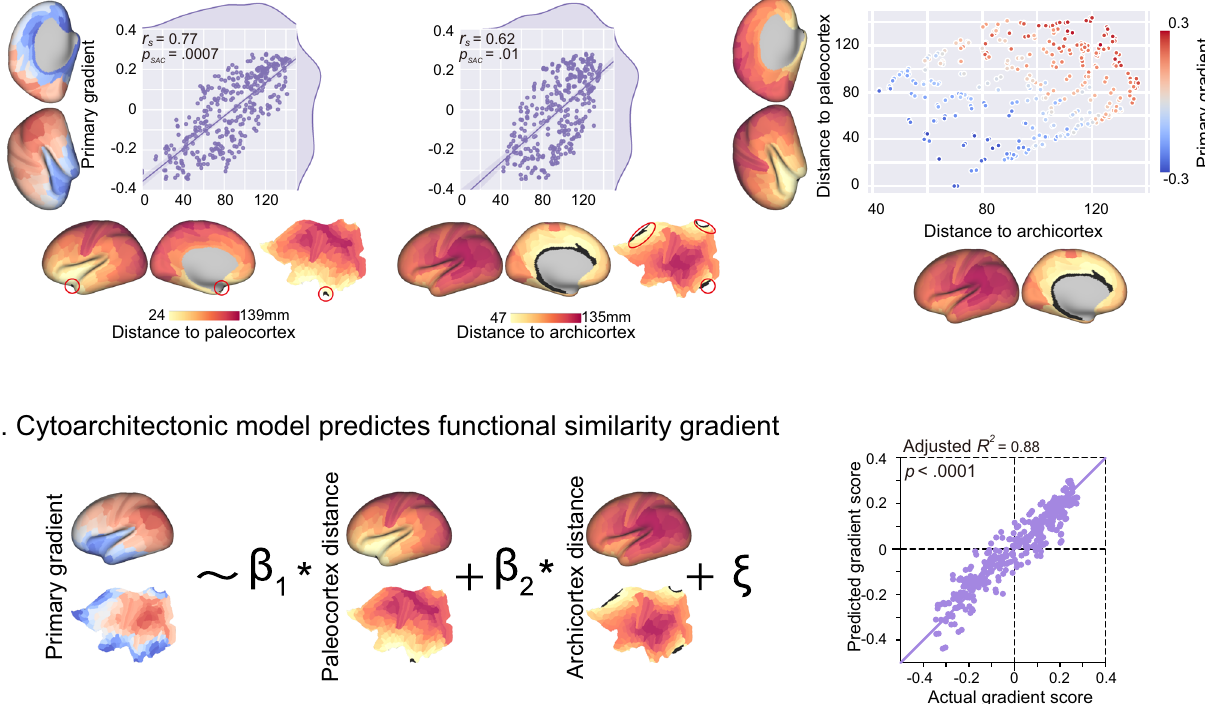
Fig. 4 The primary gradient and the cytoarchitectonic dual origin theory. a The primary gradient positively correlated with both paleo- and archicortex geodesic distance maps (Paleocortex: r s = 0.77, p SAC = 0.0007; Archicortex: r s = 0.62, p SAC = 0.01) and varied from the bottom-left to upper-right in the coordinate system de fi ned by two distance maps. Each distance map was a mean geodesic distance map, which contained the averaged distance of all seed distance maps of the region of interest (colored in black). b A linear regression model of two distance maps largely explained the primary gradient (adjusted R 2 = 0.88, p <